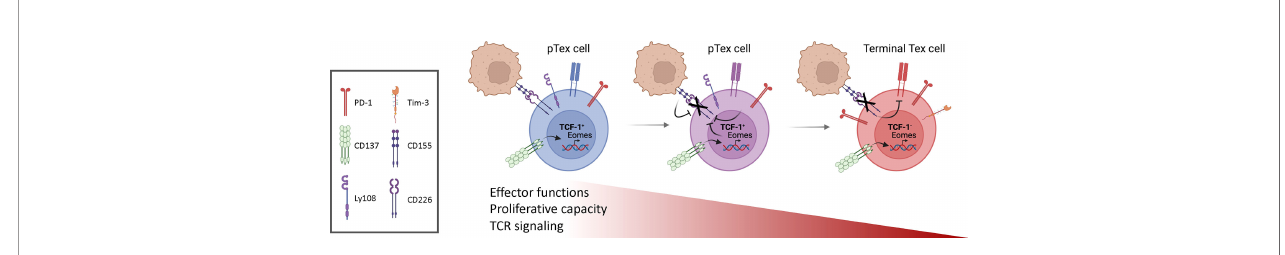
FIGURE 1 | Progressive changes in T cell exhaustion. Stem-like or progenitor exhausted cells (pTex) self-renew and, in the presence of continual antigen stimulation, give rise to more exhausted T (Tex) cells, characterized by expression of inhibitory receptors, loss of effector cell functions, proliferative capacity and their ability to respond to ICB. CD137 stimulation of early pTex cells induces high expression of Eomes, which, together with posttranslational mechanisms induced by CD155 expressed on cancer cells, drives CD226 downregulation. Loss of CD226 further impairs TCR signaling and contributes to T cell dysfunction. Figures drawn using